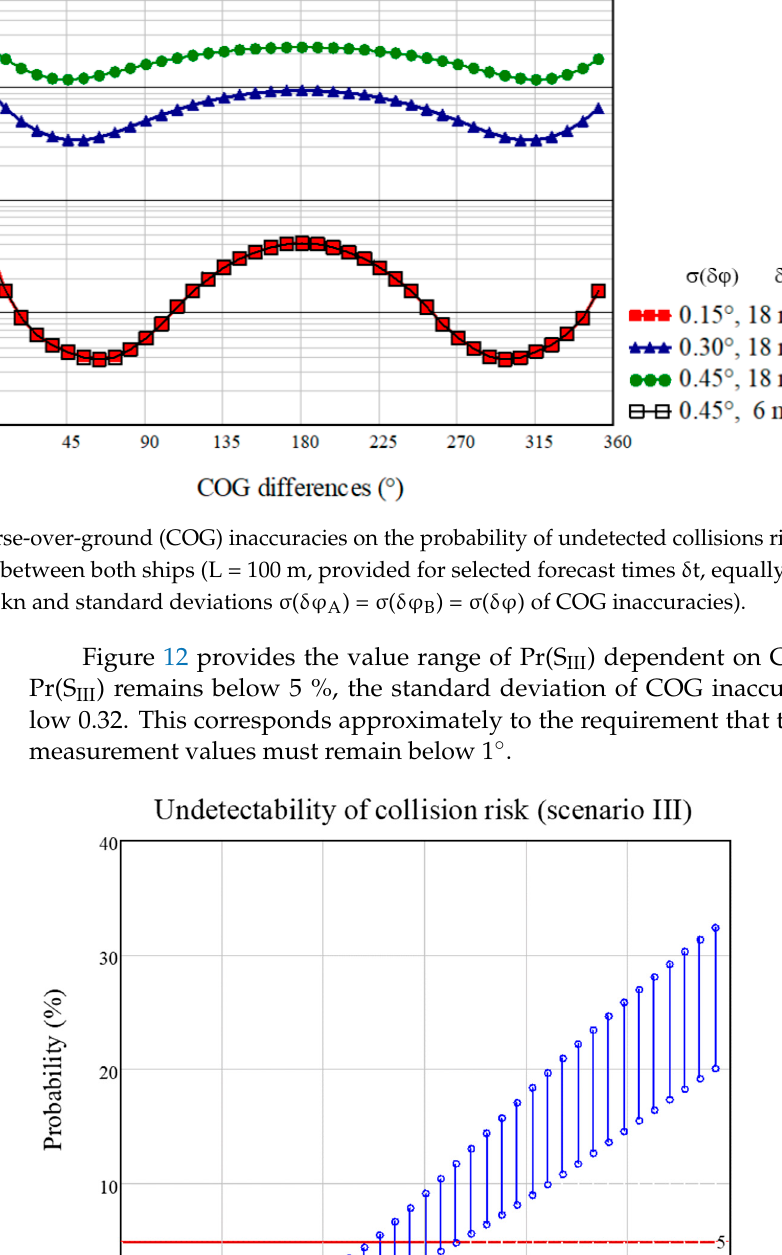
12 of 18 Figure 10. Probability of undetected collisions risks (colour-represented value range between 0 and 37.7%) dependent on the standard deviation of SOG inaccuracies with values between 0 and 0.2 kn ( ϕ A - ϕ B =+ π /4; L = 100 m; δ t = 18 min). 4.4. COG Inaccuracies The impact of inaccuracies in COG measurements on existing collision risks not being detected is given by Equation (10) and illustrated in Figure 11. The estimated CPA is determined by the ships’ course difference ϕ A - ϕ B , the measur- ing errors δϕ A and δϕ B, the forecast time δ t, as well as the SOG values S A and S B . It applies here as well that the estimate of CPA is determined by the relative ships’ motion, but not by its mapping into the traffic space. Figure 11 shows the effect of exemplarily selected COG inaccuracies on the detectability of collision risks dependent on occurred COG dif- ferences between both ships. During the simulations on which Figure 11 is based, it was assumed that the COG inaccuracies of both ships followed the same error distribution, whereby ships’ SOG was uniformly distributed between 0 and 25 kn. As expected, Pr(S III ) increased with growing forecast time δ t. Consequently, Pr(S III ) decreased also with in- creasing proximity to the real collision point. It is more surprising that curves showed identical behaviour when the product of